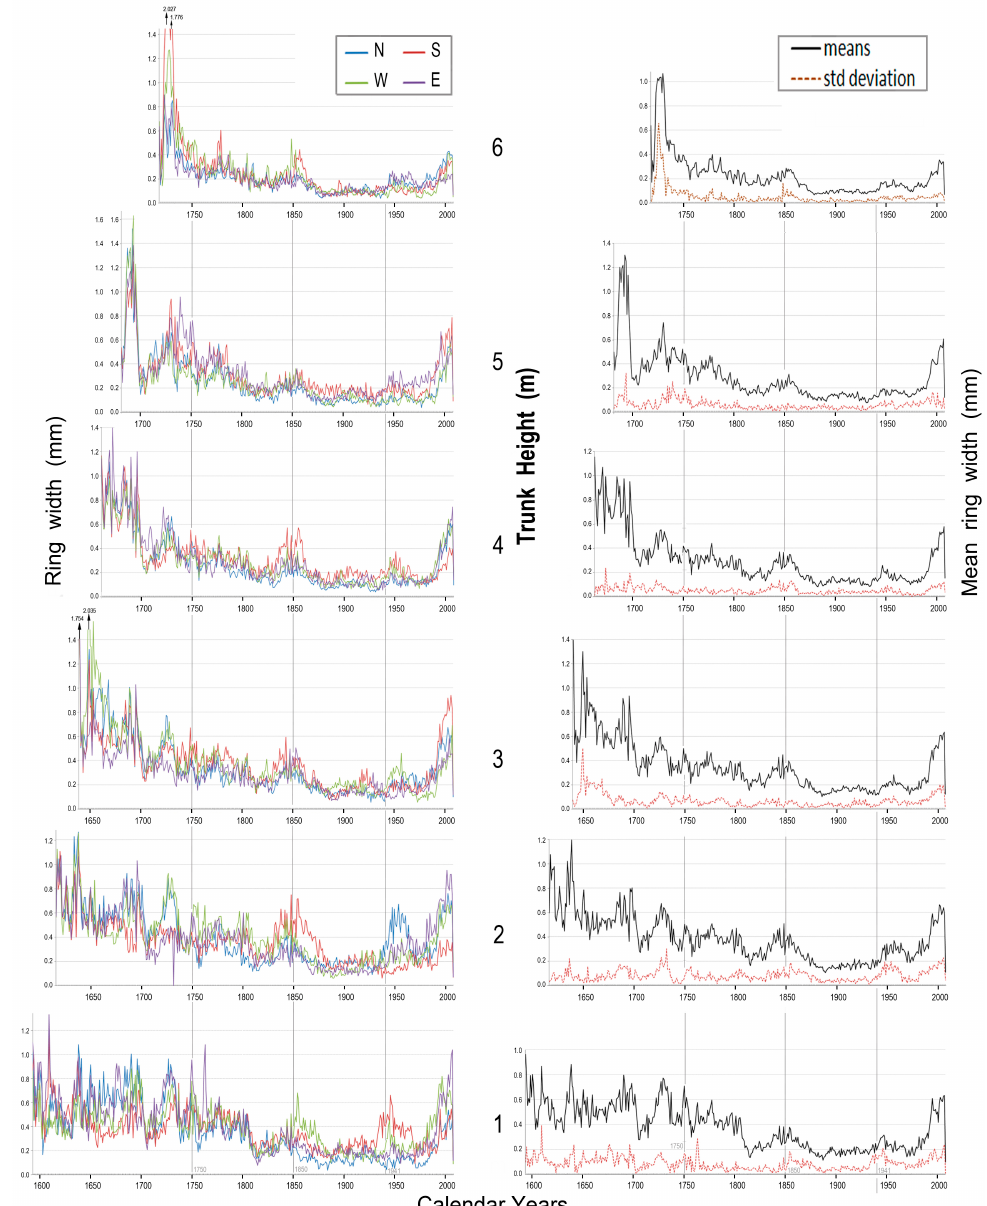
Figure 13. Tree 1311, left panel: ring widths of the four cardinal directions at six trunk heights; right panel: means of the four cardinal directions and their standard deviations.